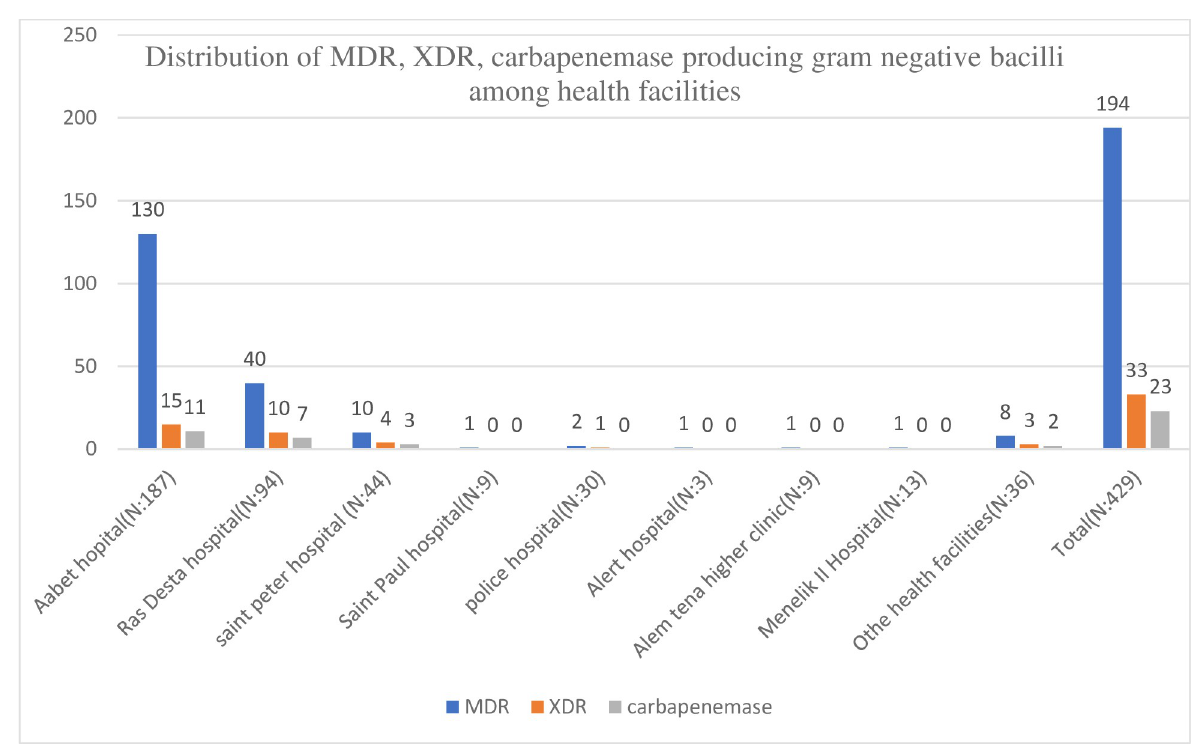
Fig 2. Distribution of MDR, XDR, carbapenemase-producing gram-negative bacilli among health facilities.